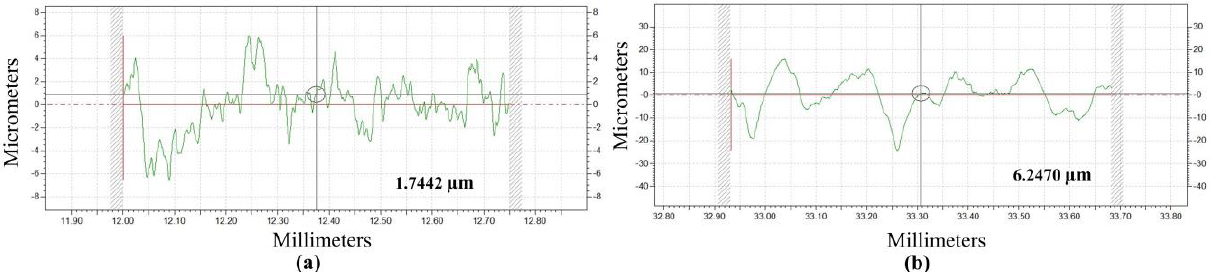
Figure 3. Roughness profiles of neat-CEC ( a ) A = 5500 rpm, B = 0.03 mm.rev −1 , C = 8 mm and ( b ) A = 1000 rpm, B = 0.07 mm.rev −1 , C = 4 mm.